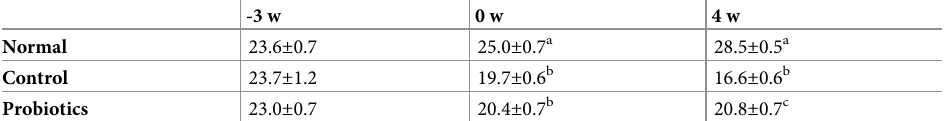
Table 16. The effect of probiotics treatment on muscle function (Permanence time) (s) in adenine-induced CKD rats.